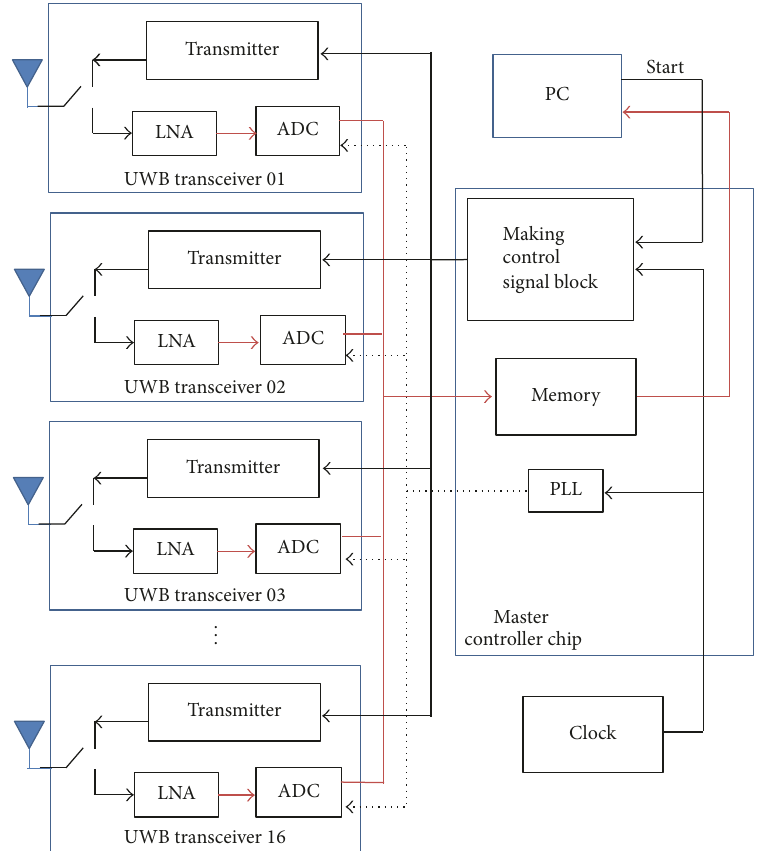
Figure 32: Block diagram of time-domain breast imaging